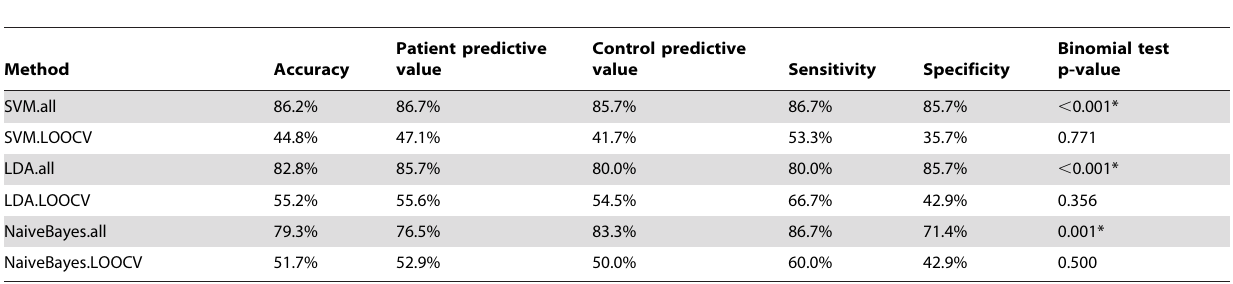
Table 3. Classification accuracy for each of the machine learning approaches: Naive Bayesian, Linear Discriminant analysis (LDA) and Support Vector Machines